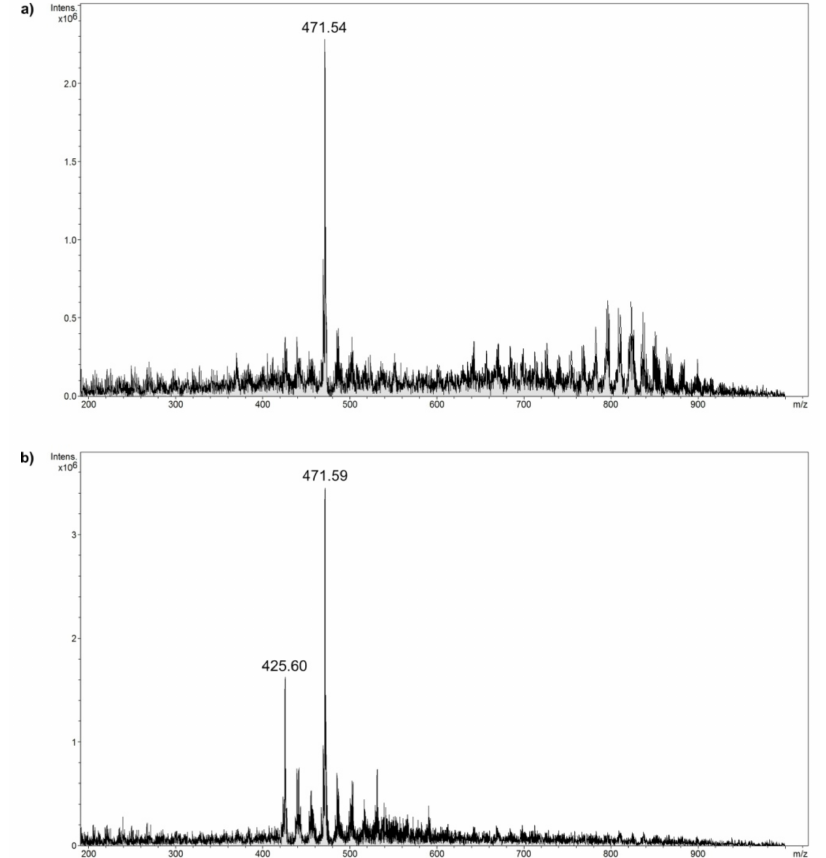
Figure 7. The FAPA–MS spectra of 18 β –glycyrrhetinic acid thermally desorbed from its complexes with: ( a ) Fe 3 O 4 –(CC–p) 2 and ( b ) Fe 3 O 4 –(CC–DETA) 2 hybrid